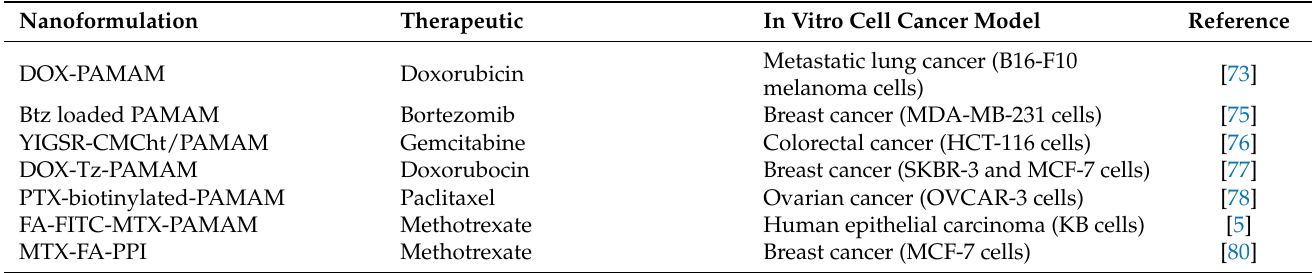
Table 4. Summary of selected dendrimers used as drug and gene